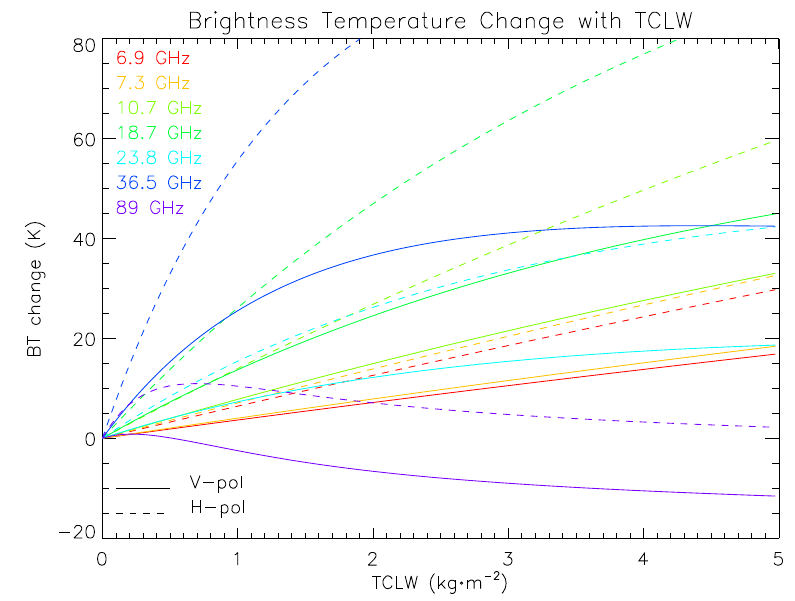
Figure 4. The change in measured brightness temperature as a function of total cloud liquid water. The data were modelled by RTTOV for the AMSR2 instrument using the same atmospheric profile but for scaled total cloud liquid water (TCLW). All channels are included ranging from 6.9 GHz (red) to 89 GHz (purple) with V-polarized channels indicated by solid lines and H-polarized channels by dashed